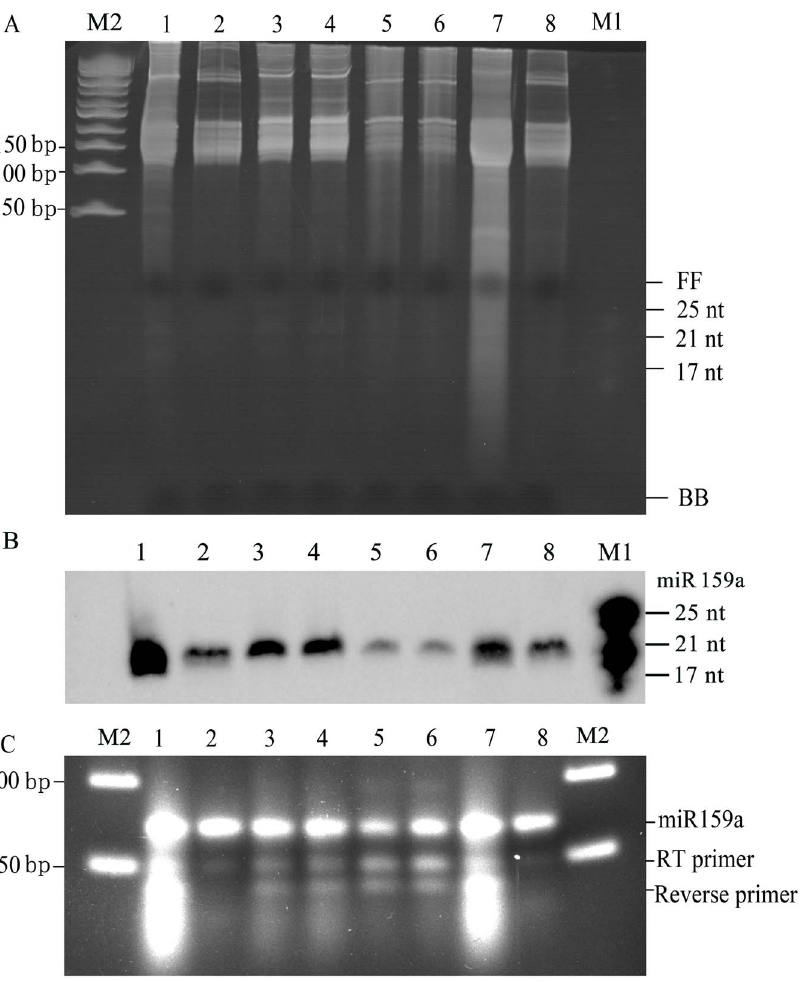
Figure 4. Analysis of small RNAs extracted from several tropical and subtropical plants. (A) Gel electrophoresis of LMW RNAs (60 m g) extracted from different tropical and subtropical plant leaves by the modified Trizol method. (B) Northern blot assay of miR159a accumulation, respectively. (C) End-point stem-loop RT-PCR (30 cycles) analysis showing the existence of mature miR159a. miR159a RT-PCR products, RT primer and forward primer used in end-point RT-PCR were visualized in the 4% agarose gel with ethidium bromide staining. Lanes 1–8 indicate guava, banana, citrus, pineapple, longan, lychee, rubber and cactus, respectively. FF: xylene cyanol FF; BB: bromophenol blue; M1: miRNA marker; M2: 50-bp DNA